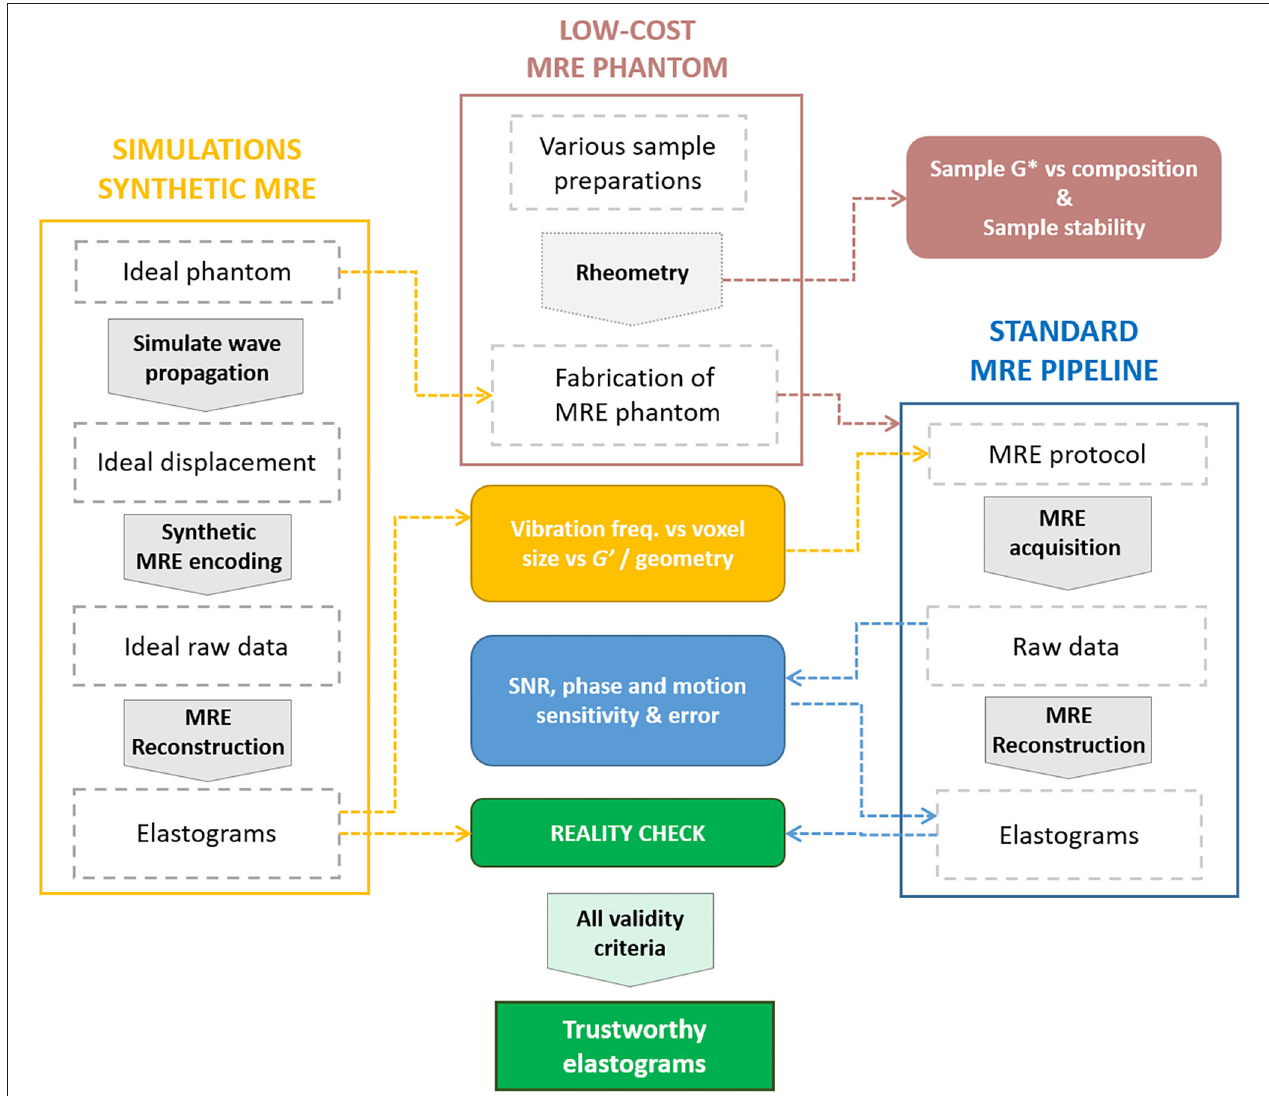
FIGURE 9 | Diagram summarizing our pipeline for MRE validation using simulations (yellow), a low-cost silicone phantom (pink), MRE experiments (blue) and the relationships between different steps (arrows). Steps are represented as dashed frames, processes as large arrows, and outputs as filled boxes.